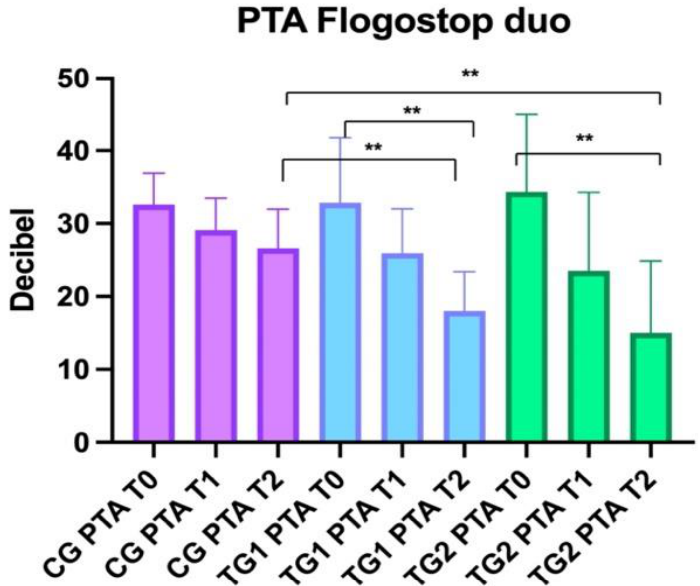
Figure 5. Comparison of PTA (pure tone average) between the three groups. Control Groups (CG), Treatment Group 1 (TG1), and Treatment Group 2 (TG2). Standard deviation “I”. The asterisk “**” indicates p < 0.01.